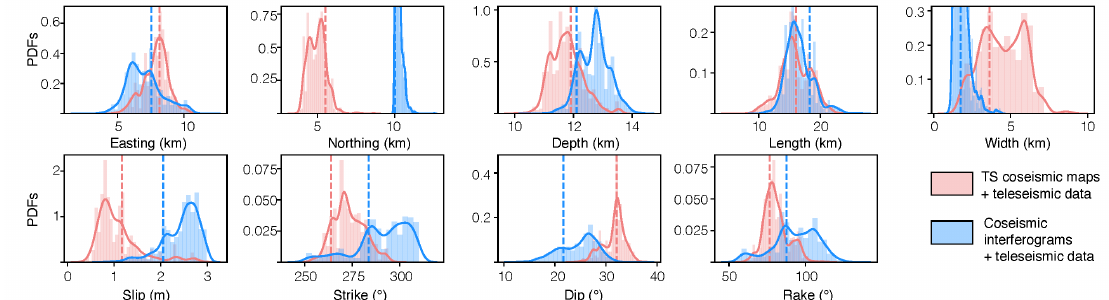
Figure 9. Comparison between posterior Probability Density Functions (PDFs) of the 2008 earthquake parameters that were obtained from the optimisation of InSAR co-seismic TS data + teleseismic data (blue) and DInSAR interferograms + teleseismic data (coral red). Dashed vertical lines are best-fitting